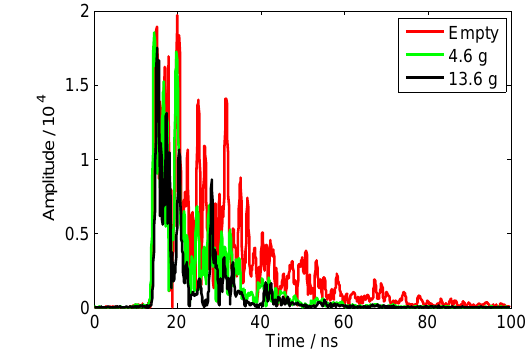
Figure 5. Envelopes of the time-domain responses from Fig. 4. this attenuates multiple-transit signals more than the single- transit (direct input-to-output) signal. In Fig. 4 the vertical scale represents A–D (analog-to-digital) counts proportional to volts as output by the analog-to-digital converter (ADC) in the UWB chip.